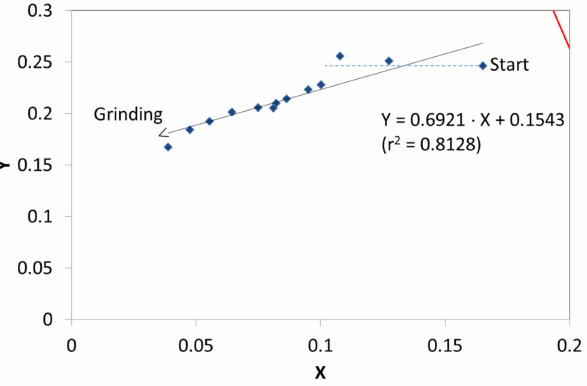
Figure 7. Triangle grain size for crushed coal blend—converted to air-dried state from wet base W r ex =